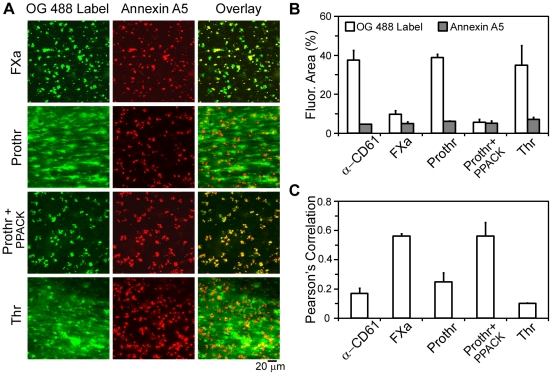
Localization of factor Xa (FXa) and (pro)thrombin on thrombi formed under shear.Human whole blood was co-perfused with CaCl2/TF at 200 s−1 over fibrinogen. Thrombi were dual-labeled with AF647-annexin A5 (14 nmol/L, red) and active-site OG488-labeled coagulation factors (1 µmol/L, green) or an antibody to the integrin β3 (α-CD61, 20 µg/ml, green). Where indicated, serine proteases were inhibited during labeling with PPACK (40 µmol/L). A, Confocal images in green are shown for OG488-labeled FXa, prothrombin (Prothr), or thrombin (Thr) fluorescence; images in red indicate annexin A5 binding. B, Fluorescence surface area coverage for each green label and annexin A5. C, Pearson's correlation coefficient, showing overlap between PS-exposing platelets and green labels. Mean ± SEM (n = 3–5).